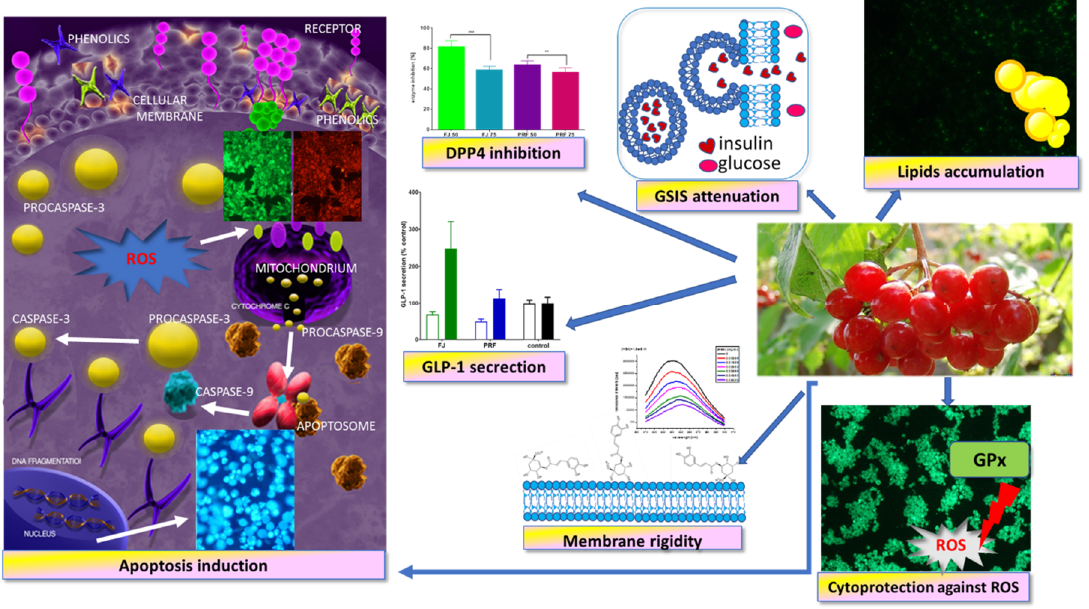
Figure 13. Viburnum opulus phenolic compounds as cytoprotective agents influencing MIN6 cell biological activity—proposed mechanism of action. They possess cytoprotective activity against ROS generation, induce apoptotic-type cell death, stimulate GLP-1 secretion, and inhibit DPP4 activity; however, they attenuate GSIS and enhance lipid accumulation.